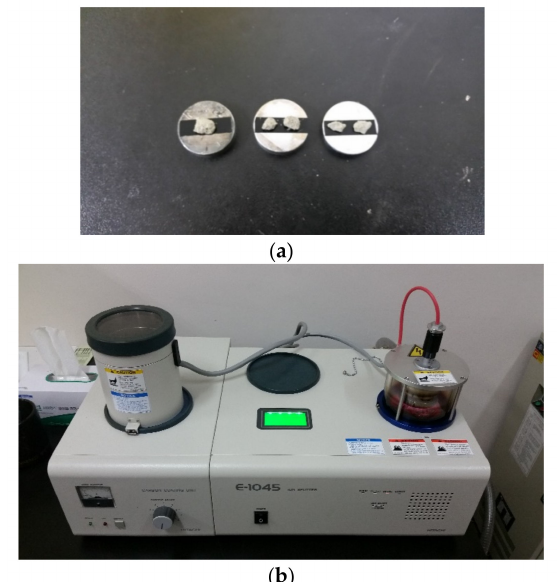
Figure 6. ( a ) Samples taken from the specimens. ( b ) Specimen surface treatment system (SEM).